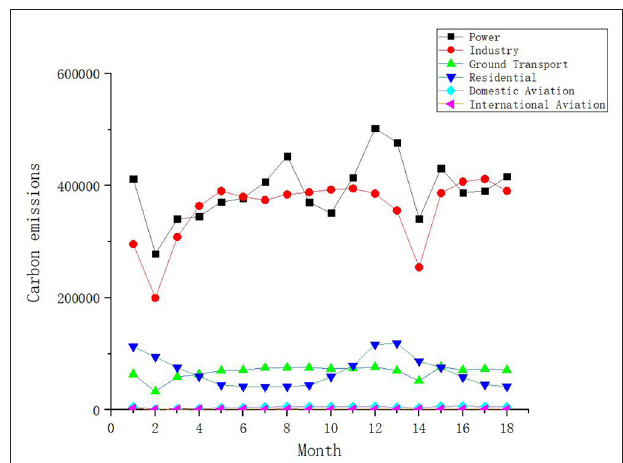
FIGURE 6 | Trends in carbon emissions by sector over the period 2020.1–2021.6.